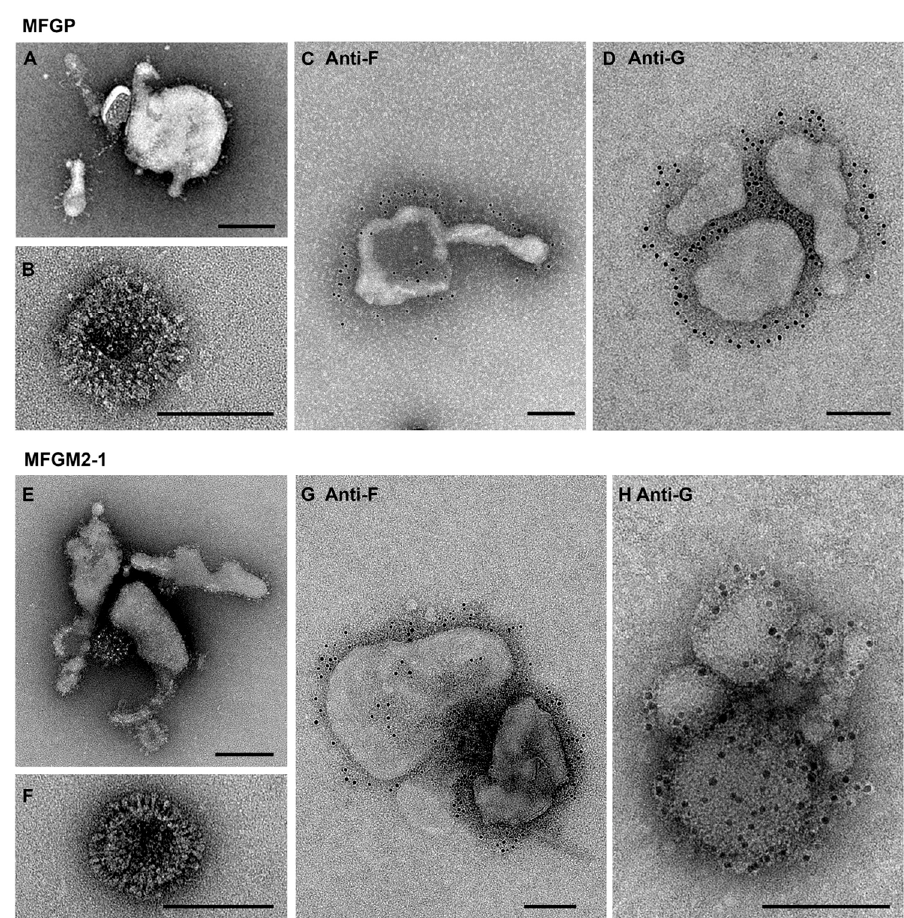
Figure 2. Electron microscopy studies show glycoproteins on the surface of RSV VLPs. Negative stain electron microscopy images showed that both MFGP and MFGM2-1 VLPs were of various shapes and sizes, displaying clear spikey glycoprotein densities on the surface ( A , B , E , F ). Immunogold labeling confirmed the presence of glycoprotein F with Palivizumab ( C , G ), and glycoprotein G with 3D3 ( D , H ) on the surface of MFGP and MFGM2-1, respectively. All scale bars are 100 nm.